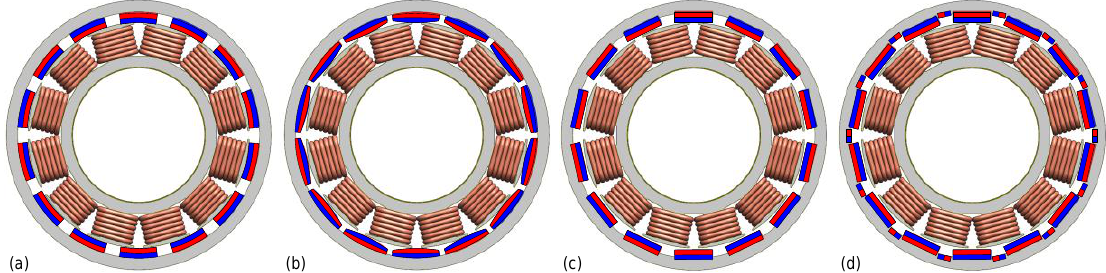
Figure 6. Proposed shapes of magnets for the ERPMSM electric machine: ( a ) with arc magnets; ( b ) with lenticular magnets; ( c ) with prismatic rectangular magnets; and ( d ) with prismatic magnets with reinforcement by Halbach array.